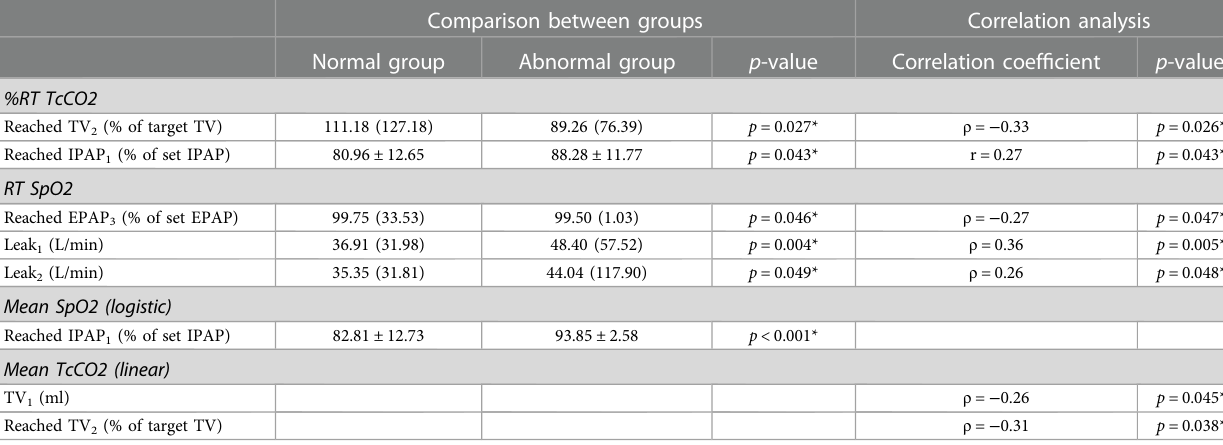
TABLE 1 Statistically signi fi cant results for comparison of baseline characteristics and BIS parameters between groups and correlation analyses for primary and secondary outcomes. Comparison between groups